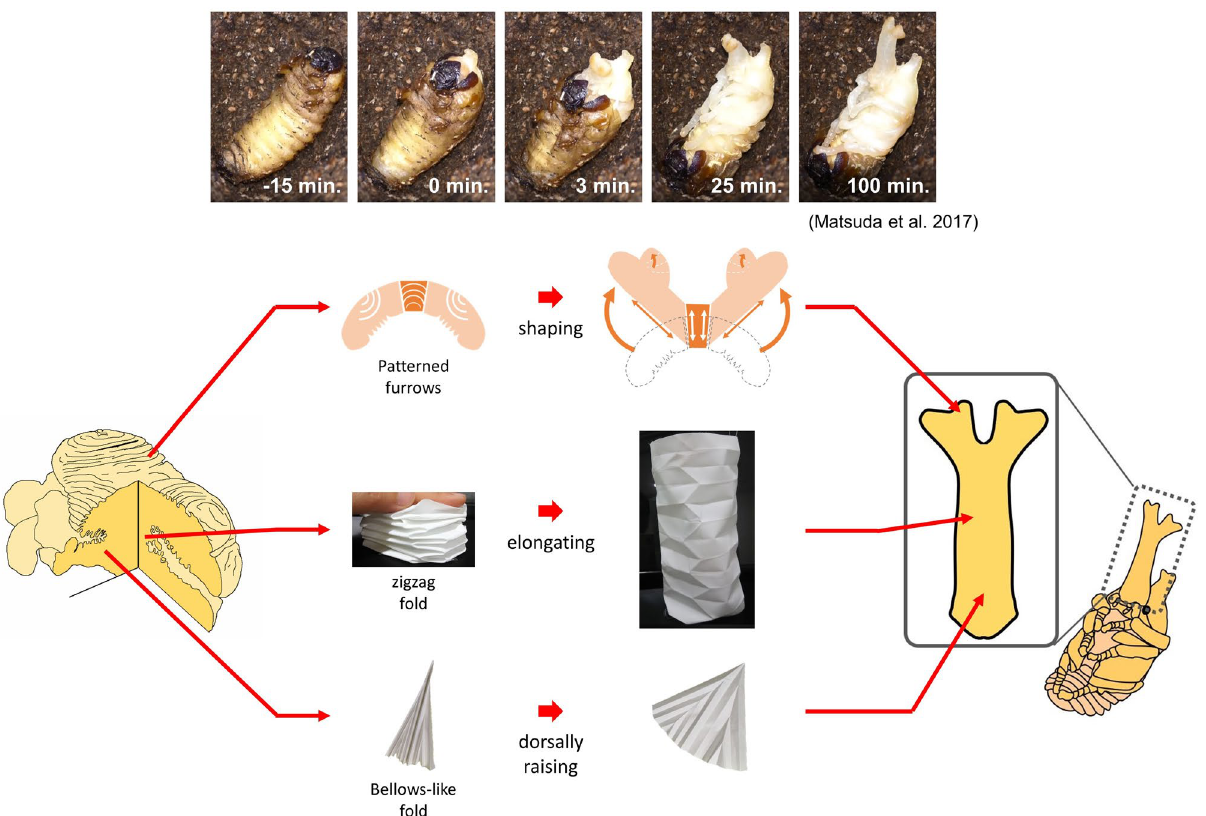
Figure 6. Various folding methods were employed in the biological 3D origami of the beetle horn. Transformation from horn primordium to pupal horn occurs within 2 h in vivo. During it, the folding of the horn primordium did not expand the entire primordium uniformly; different folding patterns in different positions contributed to the change of shape in different ways. The furrows in the base, whose distribution is biased to the ventral side, turn the orientation of the horn dorsally. In the cap, furrows have specific patterns, such as concentric semicircles and parallel straight patterns. These 2D patterns actively shaped the distal four- branched structure. On the other hand, the folding in the stalk showed features suggestive of passive formation. Wavy and zigzag folding may be formed by the bending force and longitudinal compression,